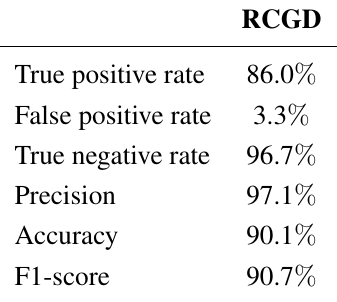
Table 3. Classification results obtained from the RCGD method for a subset of salient